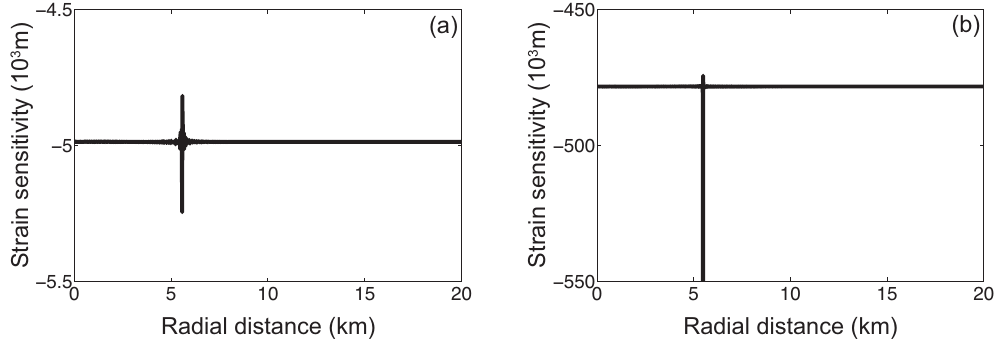
Figure 14. Strain sensitivity in the aquifers, determined by dividing simulated hydraulic head change by the volumetric strain, along a pro- file through the aquifers. (a) Pyroclastic aquifer, (b) lava flow aquifer. Very small strains close to the transition zone from dilatational to compressional strain lead to numerical errors (can be reduced with increasing mesh density).